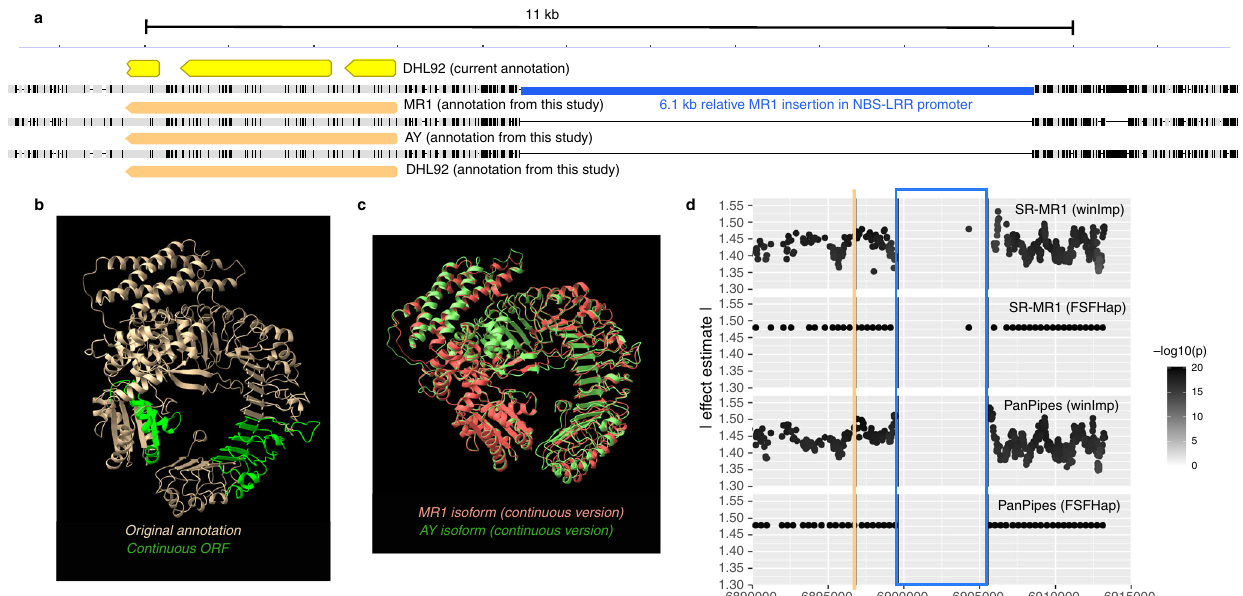
Fig. 5 | Causal variant analysis of fom2 locus. a Nucleotide-level depiction of parentandDHL92alignmentsacrossthe fom2 locus.Thepre-existing3exonmodel of the NBS-LRR protein is shown in yellow; our single-exon annotations are shown in orange. The ~6.5kbinsertion in MR1 ’ s promoter region ofthe NBS-LRR isshown in blue. Gray indicates identical bases across all three lines. Black lines re fl ect var- iant columns. b AlphaFold2 predictions of continuous open reading frame (ORF) models with green re fl ecting the included introns. c MR1 and AY isoforms of the